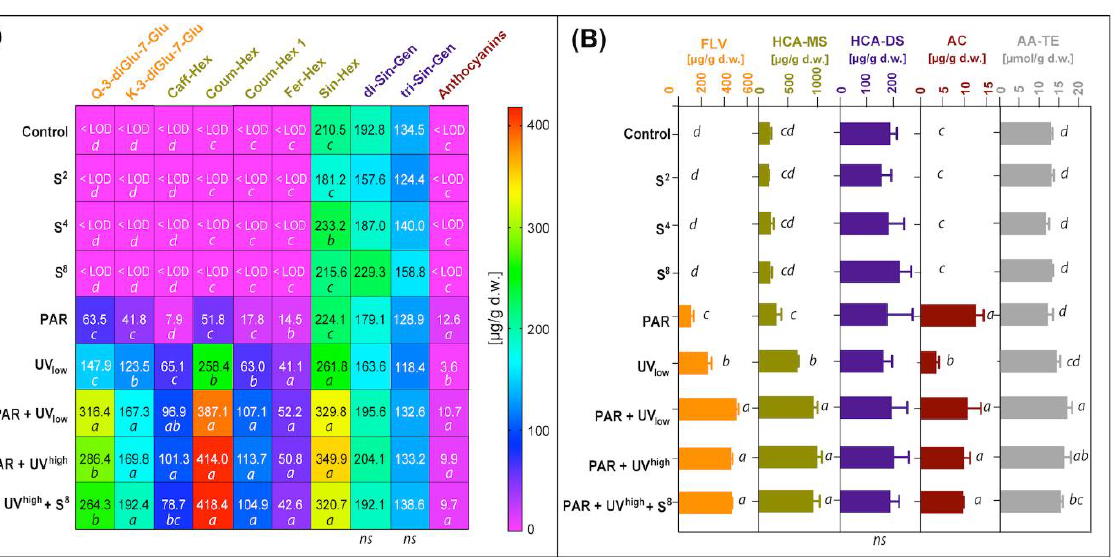
3-(methylsulphinyl)propyl isothiocyanate (2.1 to 2.6 µmol ∙ g − 1 d.w.) (Figure 4E).